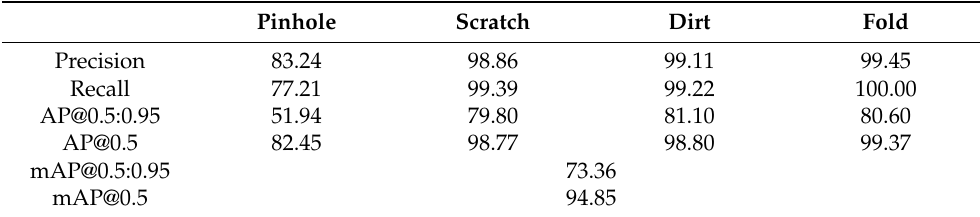
Table 1. Test results for four types of defect